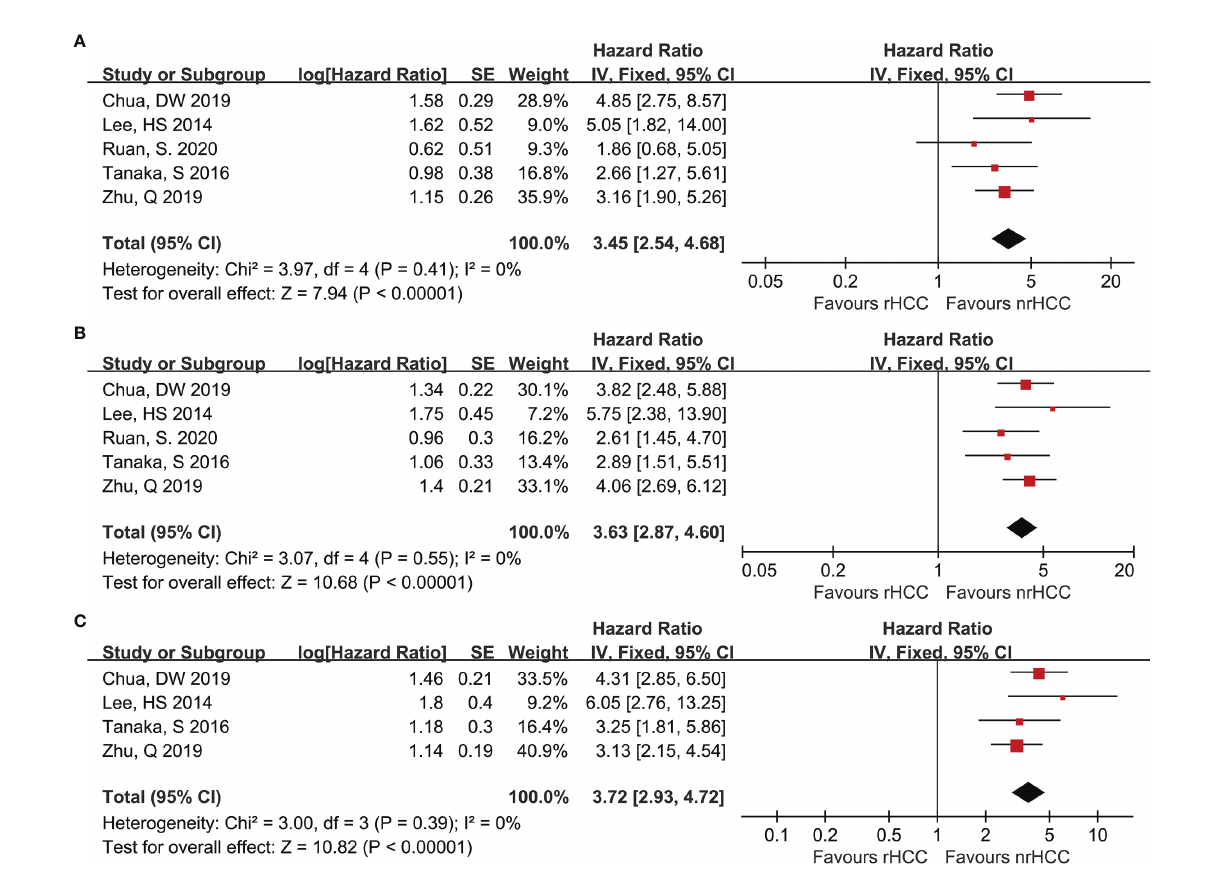
FIGURE 2 | Forest plots for DFS. (A) Forest plot for 1-year DFS indicates signi fi cantly decreased DFS in the rHCC group as compared with that in the nrHCC group (HR, 3.45; 95% CI: 2.54 – 4.68). (B) Forest plot for 3-year DFS indicates signi fi cantly decreased DFS in the rHCC group (HR, 3.63; 95% CI: 2.87 – 4.60). (C) Forest plot for 5-year DFS indicates signi fi cantly decreased DFS in the rHCC group (HR, 3.72; 95% CI: 2.93 –